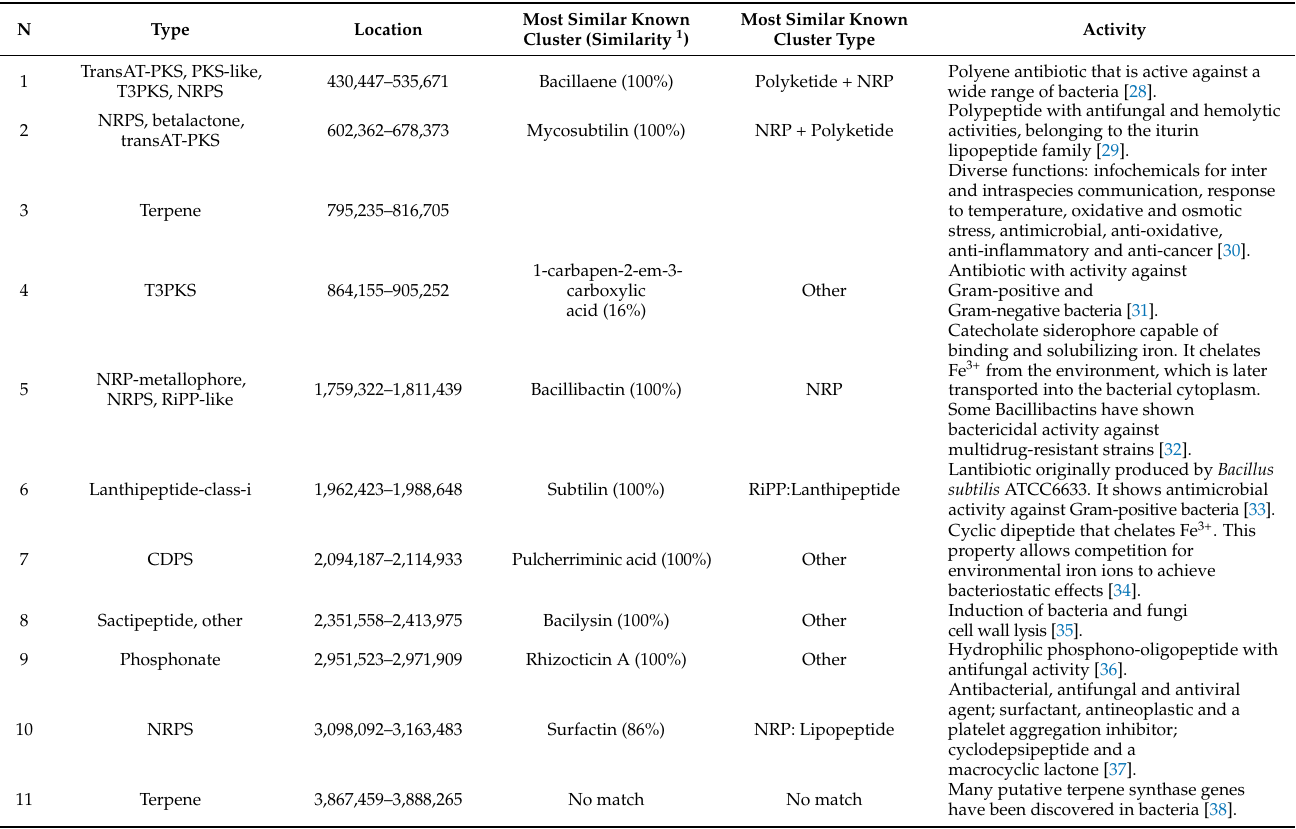
Table 3. antiSMASH detected regions of secondary metabolite biosynthesis gene clusters in the MC6B-22